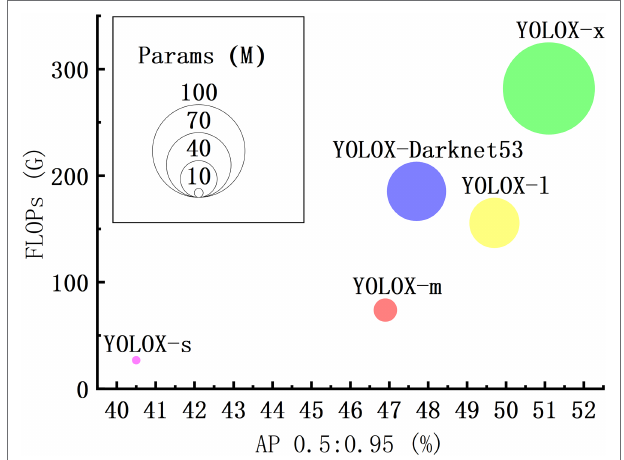
FIGURE 3 | Accuracy, number of parameters, and computational overhead of each YOLOX model.